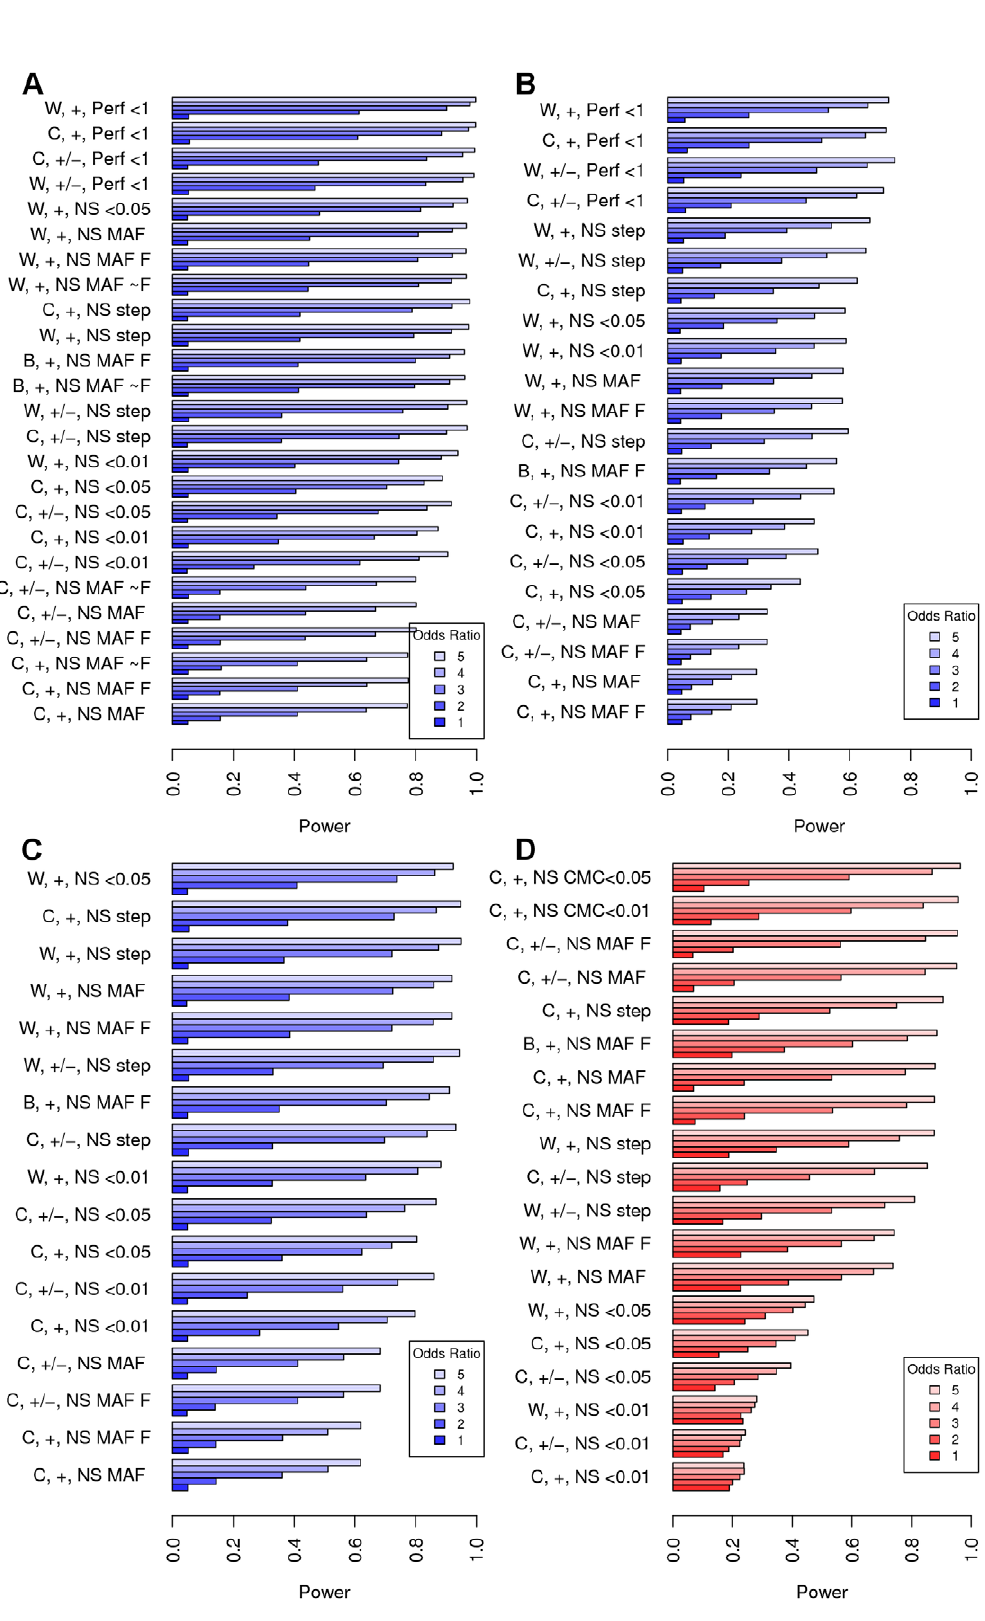
Figure 2. Results from simulation study comparing power for rare variant analysis approaches. 500 simulations were based on haplotype distribution for each of 13 deep sequenced candidate genes, and averaged. 500 permutations were run per test. Information for each situation on the bottom of each plot consists of three parts that indicate the test used: a k (‘C’ for constant, ‘W’ for weighted by allele frequency); s k (‘ z = { ’ if signed, ‘ z ’ if constant); and the range of groupings v k (‘NS’ for nonsynonymous, ‘F’ for all protein coding, ‘ * F’ for nongenerating protein coding, ‘MAF’ for all MAF, ‘step’ for step-up, and ‘Perf’ for the exact generating alleles when appropriate). Results in plots A-C are sorted by the plot that has the highest area, i.e., the most powerful overall. In D, each value of F indicates how much common variants affect disease and must be considered separately; to emphasize this, we have sorted by the power when F ~ 5 . doi:10.1371/journal.pone.0013584.g002 PLoS ONE |